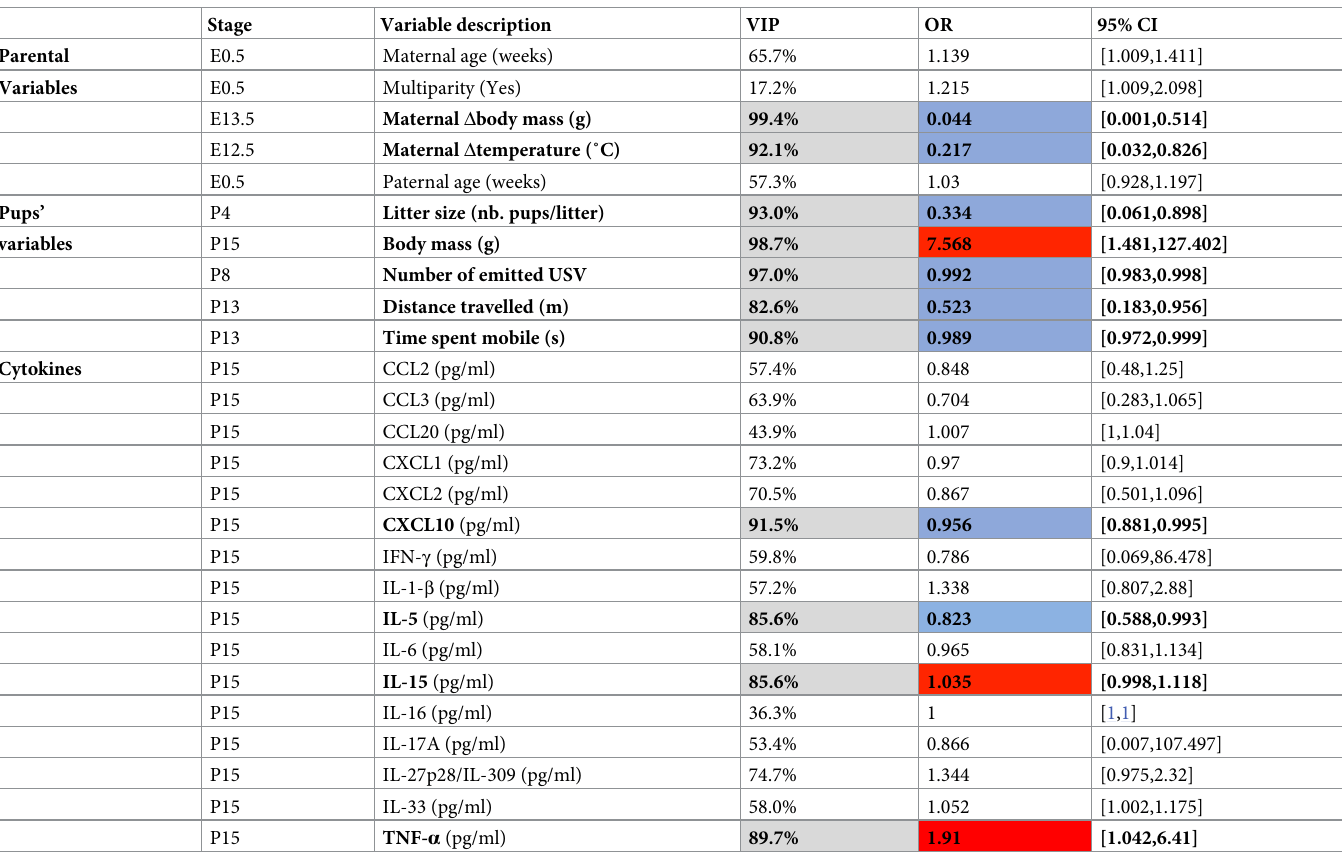
Table 1. Associations between cytokine levels at P15 and MIA adjusted for confounders and covariates. VIP, mean ORs and 95% CI are shown for the indicated vari- ables. The VIP can be interpreted as the posterior probability of a given variable contribute to the model and is therefore an estimate of the stability of the association. Vari- ables with VIPs above 80% (grey) were considered as stably associated with MIA. Positive (red) and negative (blue) associations are